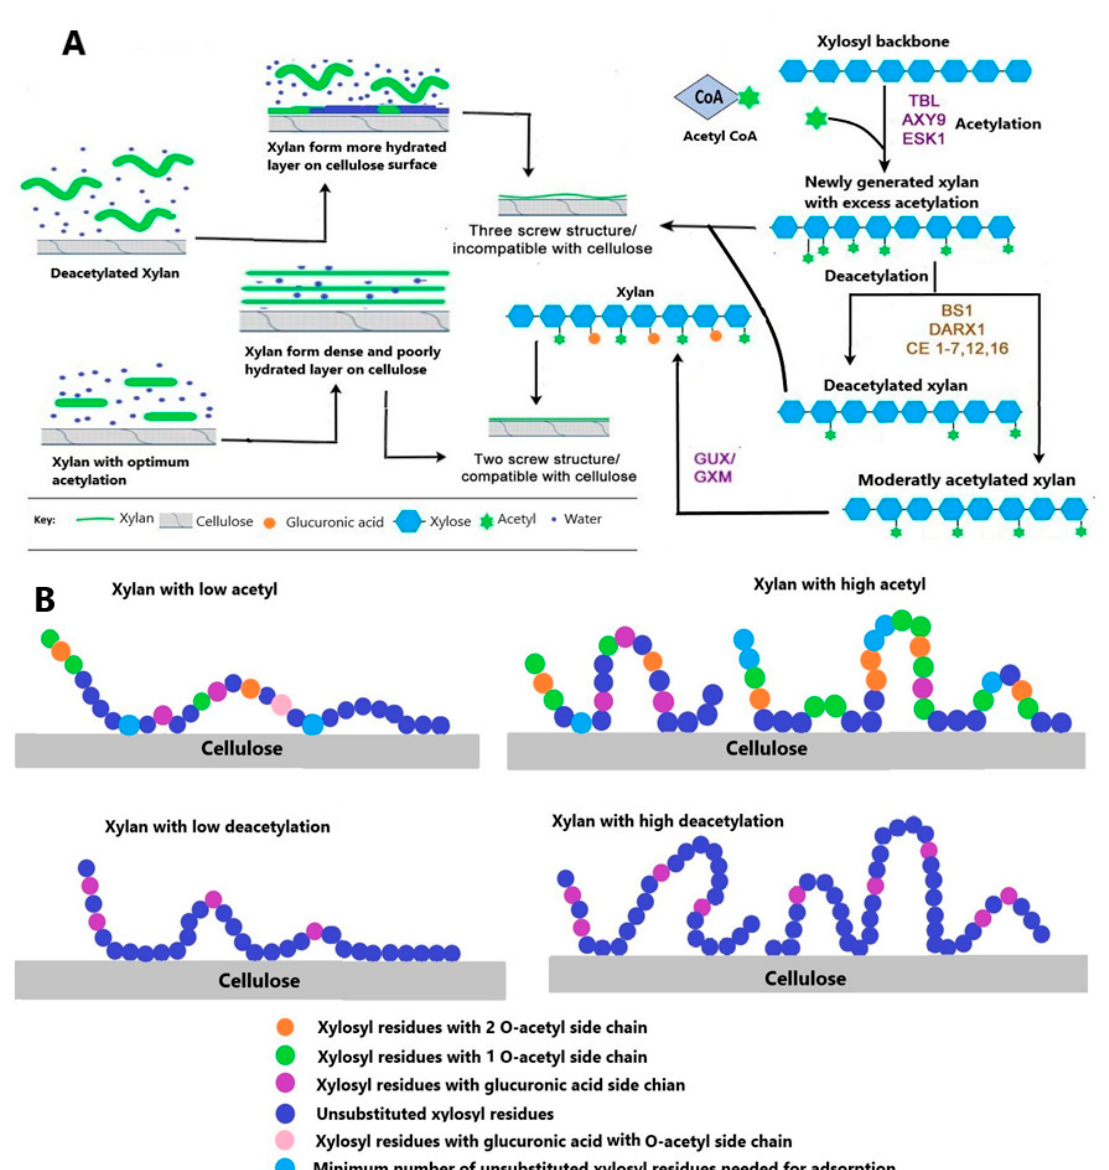
Figure 4. ( A ) Hypothesis of xylan acetylation and deacetylation and its binding with cellulose: the action of various Trichome Birefringence-Like genes ( TBLs) in other acetylation catalyzing genes followed by GUX/GXM add acetyl and glucuronosyl (U) or 4-O-methylglucuronosyl (U Me ) residues respectively to generate even-patterned xylan that is compatible with binding to the cellulose hydrophilic surface. In some cases, TBLs place an overloaded acetyl group on the same xylosyl residue, which is already substituted by a U Me , thus generating doubly acetylated xylosyl. Access of acetylation is removed by xylan esterase belonging to different classes and a member of GDSL esterases. The other half of the figure explains the effect of acetylation on a xylan cellulose complex. The xylan with excess acetylation or that is highly deacetylated forms a viscous and highly hydrated layer on the cellulose surface, while xylan with optimum acetylation forms a dense layer with tight bonding between xylan and cellulose. ( B ) The proposed mechanism of xylan adsorption extracted from Eucalyptus wood on bacterial cellulose surface modified from [100].